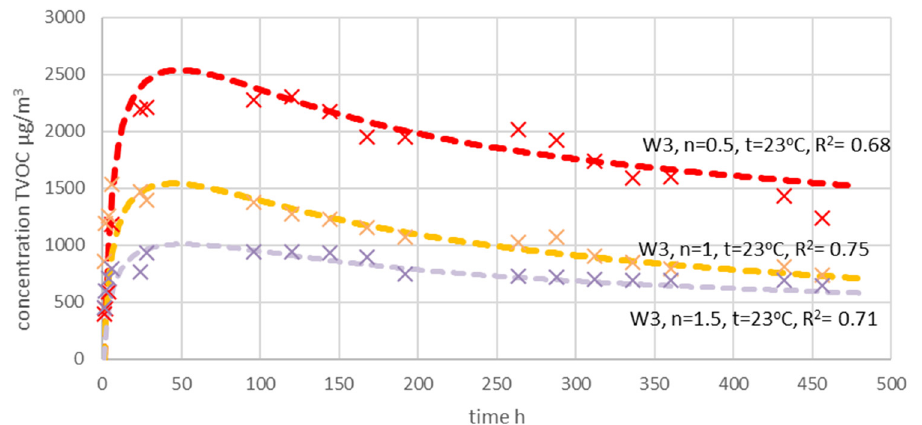
Figure 8. The TVOC emission profiles from W3 sandwich floor systems (testedfor480 h) for three air changes rates ( n = 0.5 h − 1 , 1 h − 1 and 1.5 h − 1 ) at 23 °C and RH = 80% in the emission test chamber. (W3 sample is system is made of: polyurethane solvent primer, polymer–cement waterproofing and epoxy adhesive (see Table 3); significant VOCs compounds for these products are provided in Table 1).